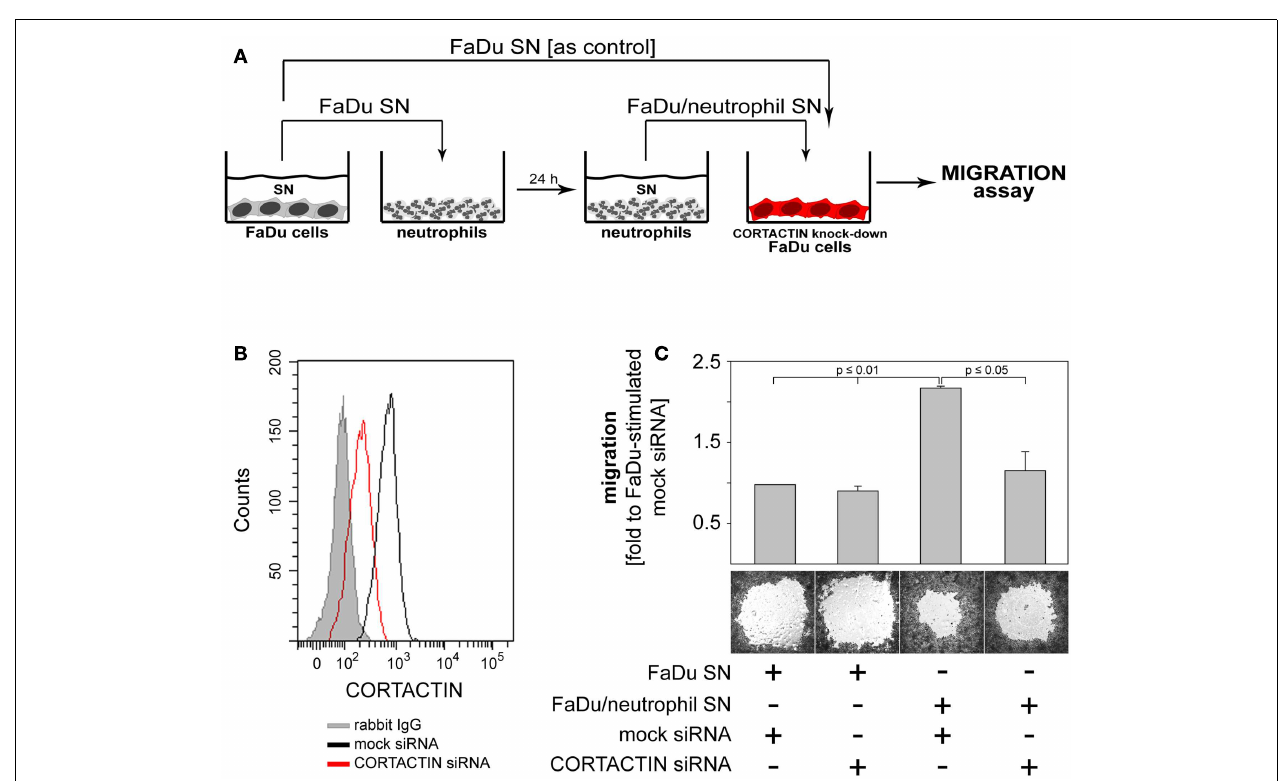
to the cell-free round area visible in the figure. Stimulation was performed as indicated in A. Cells were fixed/stained with a solution containing crystal violet and micrographs were taken at 25-fold magnification. “Gap”-closure was quantified with the ImageJ software. Data are means ± SD of three independent experiments (upper panel). A representative result is shown in the lower panel of the figure. Statistical testing was performed with the two-tailed paired Student’s t